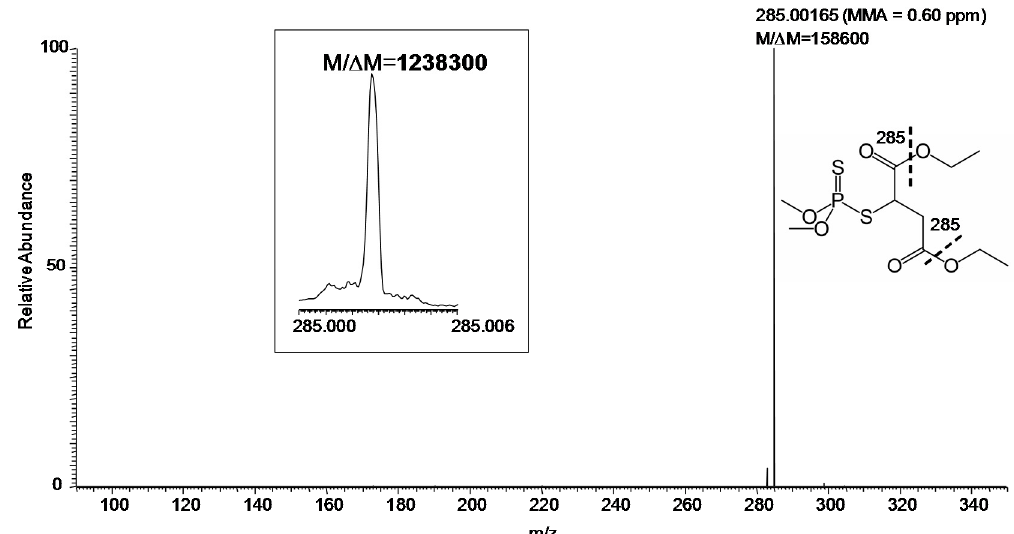
Figure 3. Product ion MS/MS of protonated malathion ( m/z 331) from a sample collected by swabbing from the field (Figure 1) followed by DART–MS using a hybrid mass spectrometer with CID in the linear ion trap and fragment ions detected in the FT-ICR (set M / Δ M of 100,000 FWHM at m/z 400). Inset: The fragment ion m/z 285 (set M / Δ M of 500,000 FWHM at m/z 400). The fragmentation leading to the observed ion is indicated by the thick dashed line on the displayed structure of the compound.